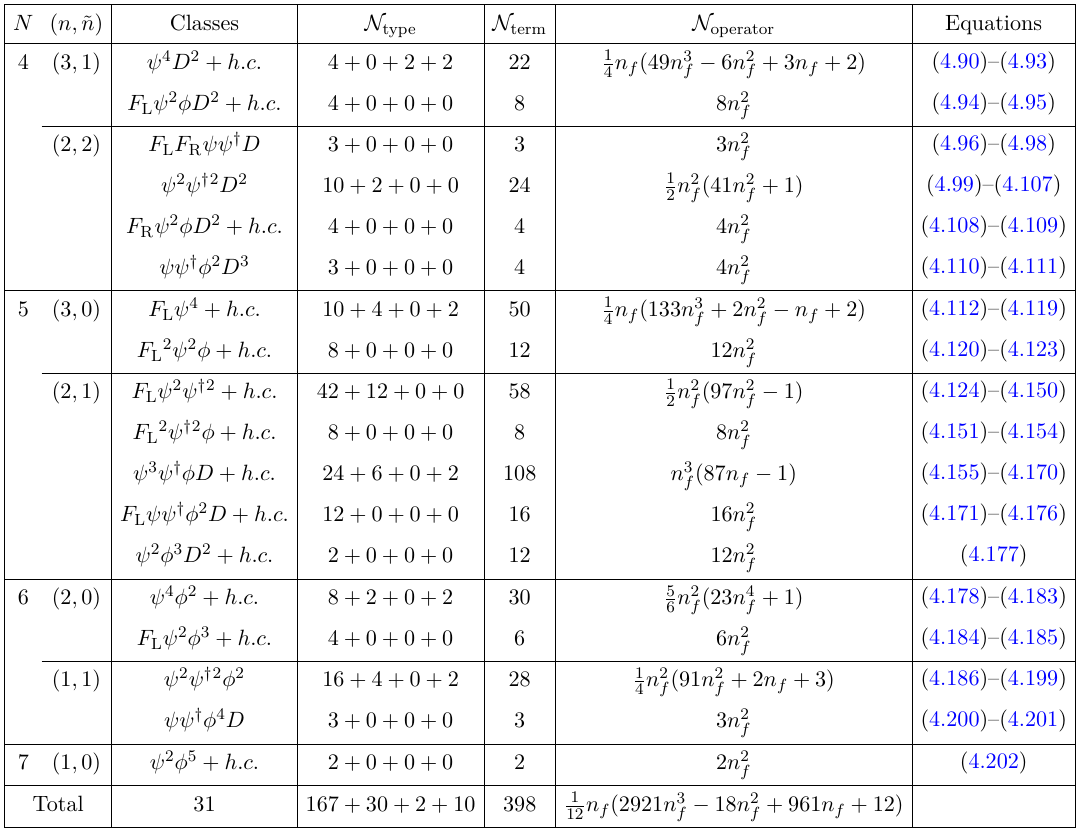
Table 4 . The complete statistics of dimension 8 ν SMEFT operators. The numbers under N type describe the sum of each possible | ∆ L | types/operators with N = N ( | ∆ L | = 0) + N ( | ∆ L | = 1) + N ( | ∆ L | = 2) + N ( | ∆ L | = 4)